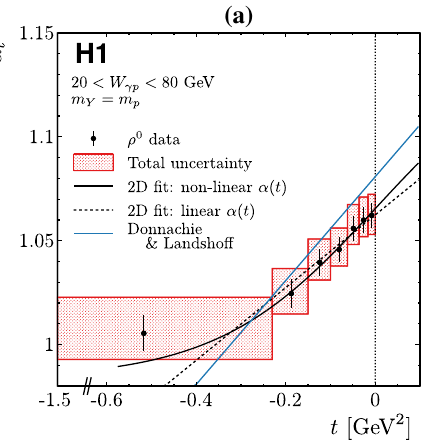
The trajectories extracted from a Regge model fit to the W γ p and t dependencies are shown as solid curved lines (non-linear ansatz) and as a dashed line (linear ansatz). In panel a , the Donnachie–Landshoff trajectory is also shown